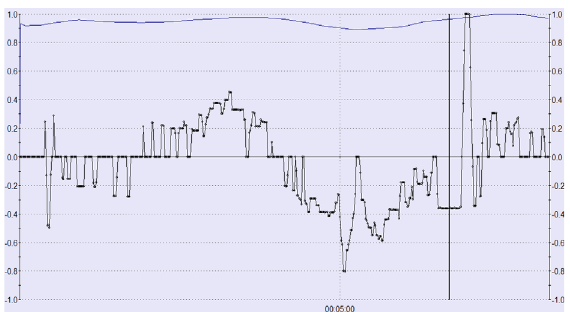
Fig. 15. Hydrodynamic influence between the PANAMAX tanker and a ferry expressed as rudder rotation in the narrow channel in the parallel direction at very short distances (vertical line in the figure corresponds to the ship position indicated in Fig. 14)